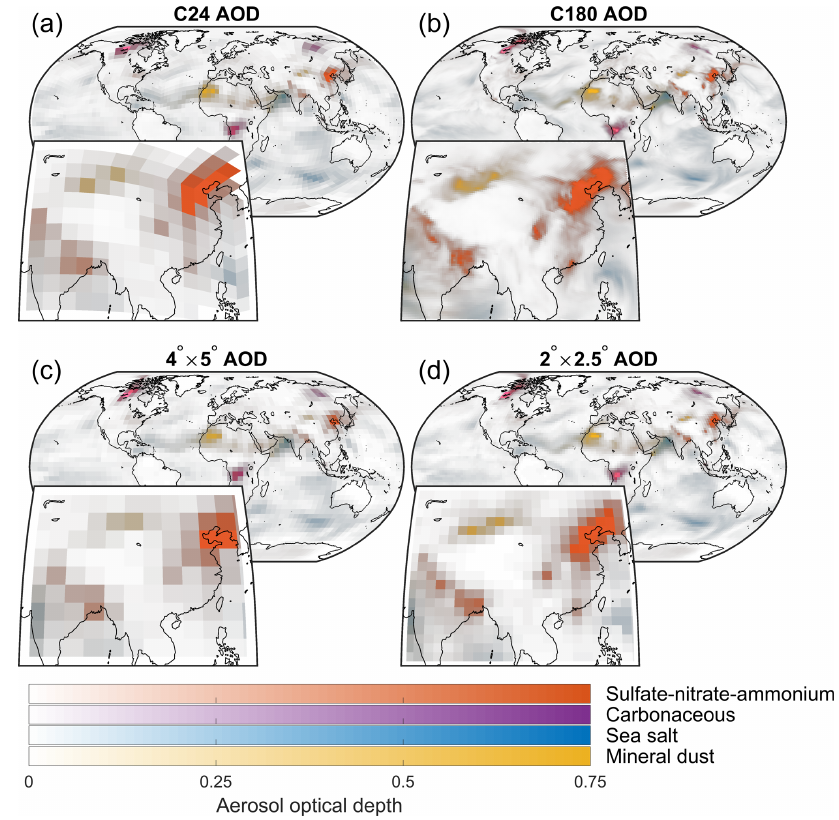
Figure 6. As for Fig. 5 but now showing daily average aerosol optical depth for 31 July 2016, after 1 month of